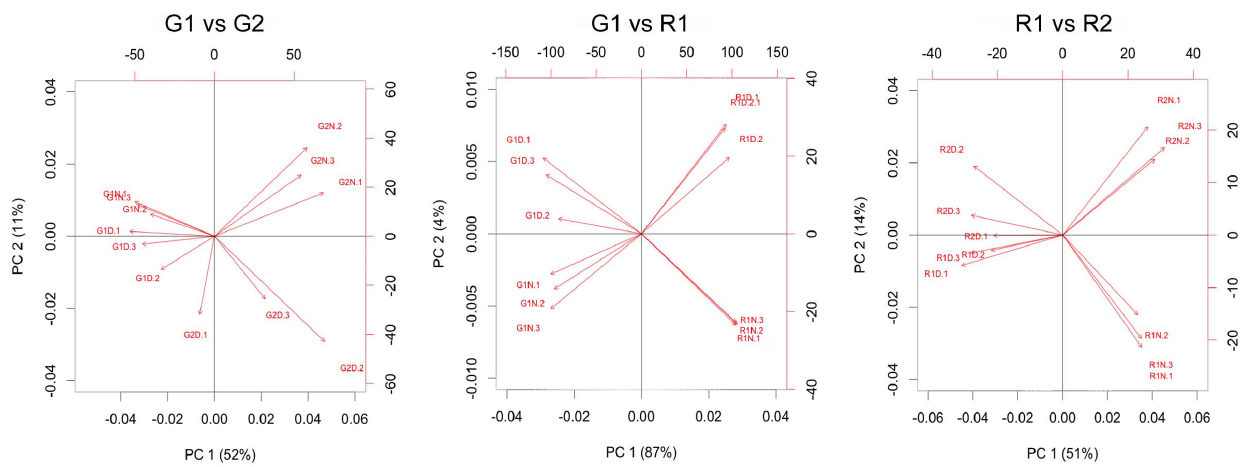
Figure 2. Principal component analysis separately on green stages (left), ripe stages (right) and between green and ripe (middle) during the day and night.